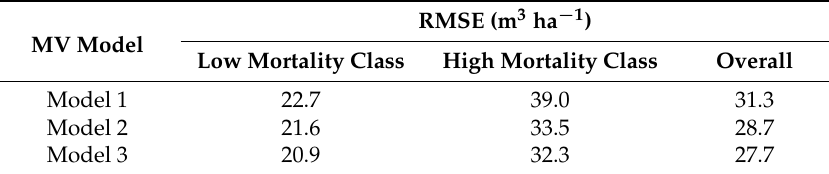
Table 6. Root mean square errors (RMSEs) of the merchantable volume (MV) models presented by the class of